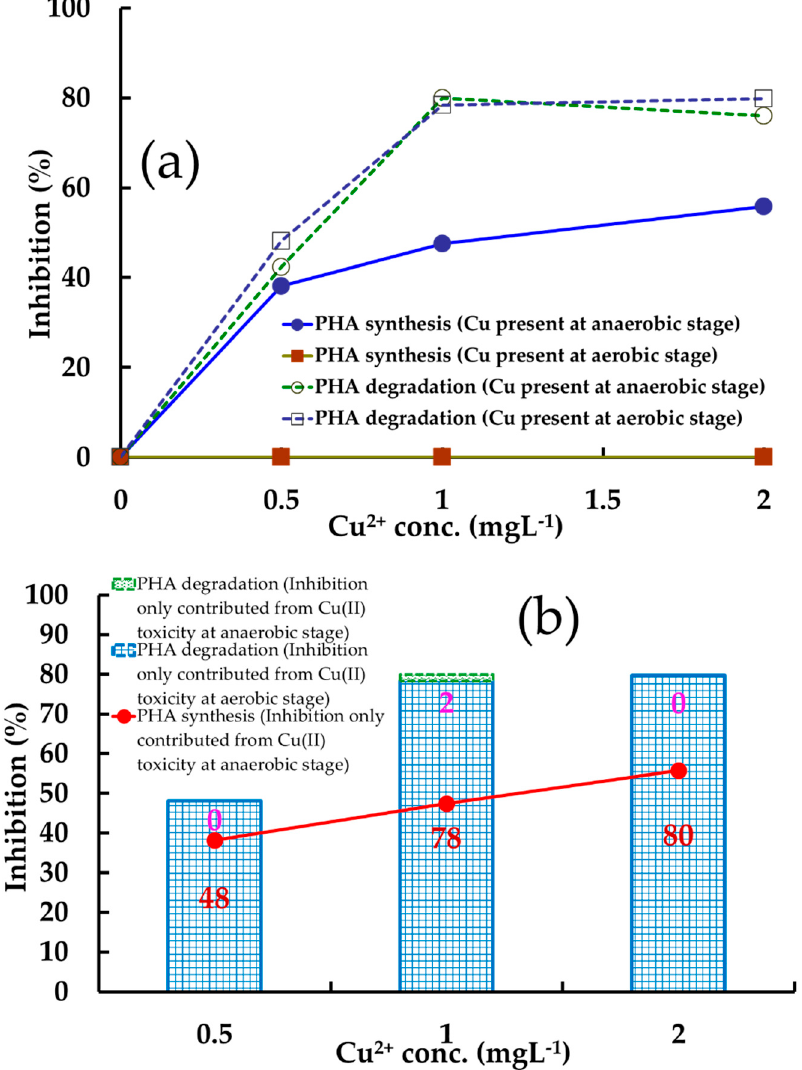
Figure 5. Cu(II) inhibition of PHA metabolisms at 20 °C. ( a ) Cu(II) appearance at different stages; ( b ) inhibition contributions from different stages.